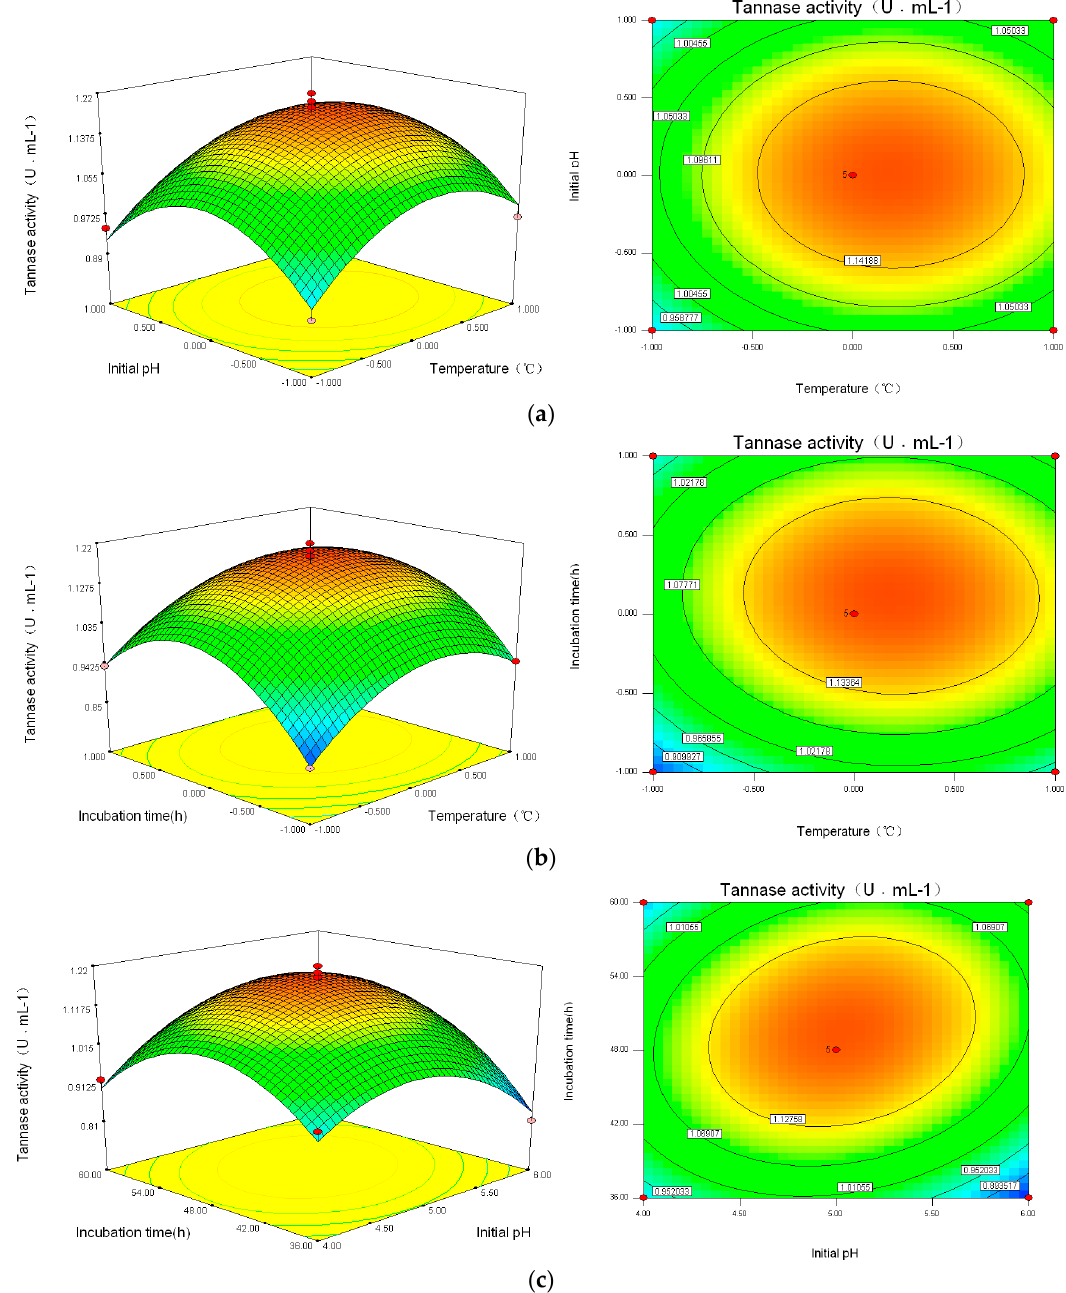
Figure 4. Contour plots and 3D-response surface plots showing ( a ) the interactive effects of incubation temperature and initial pH ( X 1 X 2 ); ( b ) incubation temperature and incubation time ( X 1 X 3 ); and ( c ) initial pH and incubation time ( X 2 X 3 ).